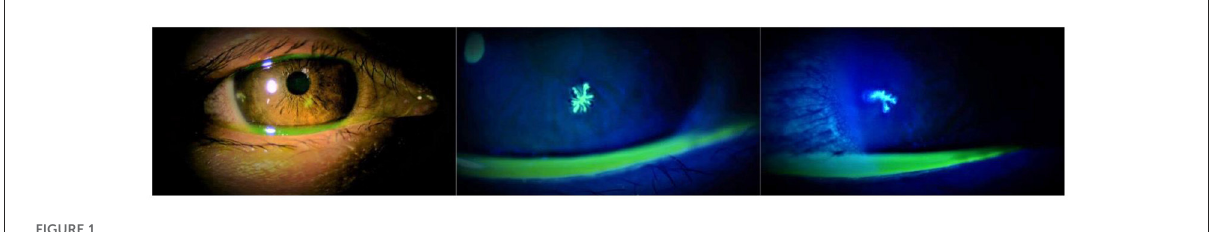
FIGURE1 Slit-lamp examination of the right eye of the patient showing a herpes keratitis that occurred on the day after the third dose of BNT162b2 (Pfizer). Photos were taken 2 days after the